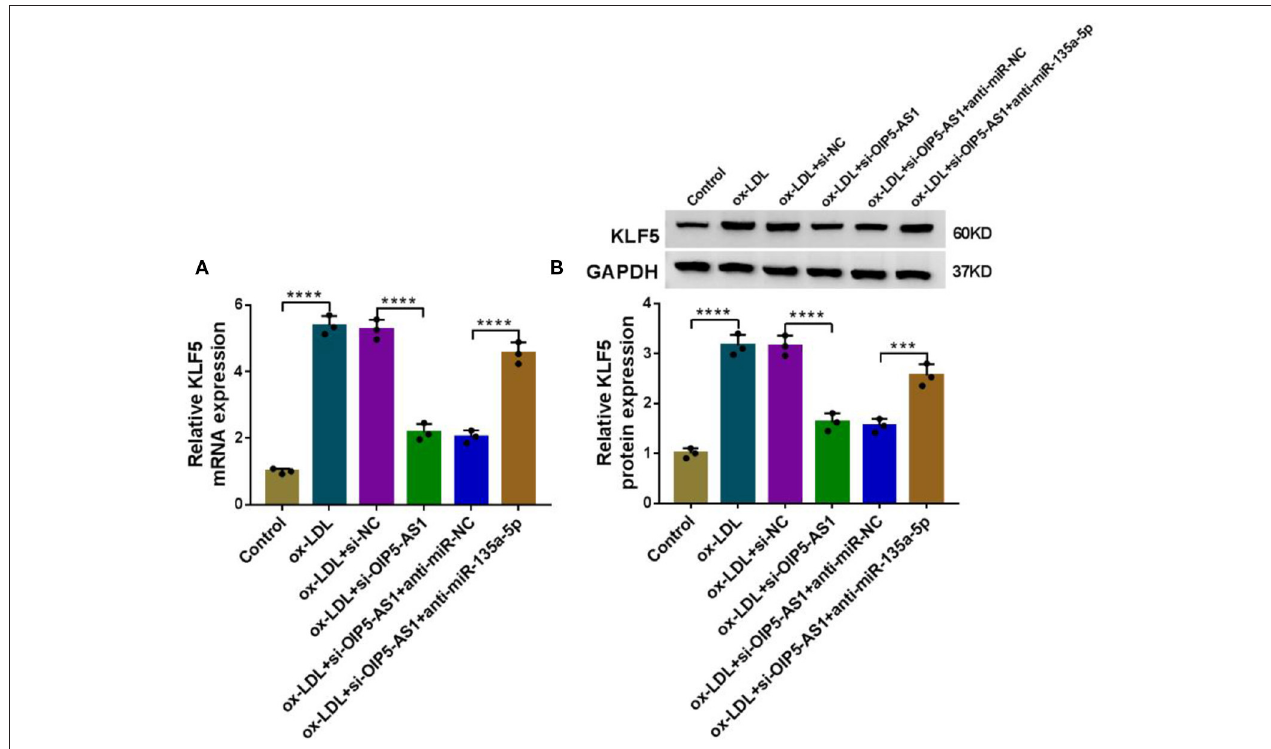
FIGURE 7 | OIP5-AS1 regulated KLF5 expression through sponging miR-135a-5p. KLF5 mRNA expression determined by qRT-PCR (A) and KLF5 protein level by western blot (B) in HUVECs transfected with si-NC, si-OIP5-AS1, si-OIP5-AS1 + anti-miR-NC, or si-OIP5-AS1 + anti-miR-135a-5p before stimulation with ox-LDL (40 µ g/ml, 24h). n = 3 independent biological replicates; error bars represented SD; *** P < 0.001 or **** P < 0.0001 by one-way ANOVA with Tukey’s post hoc